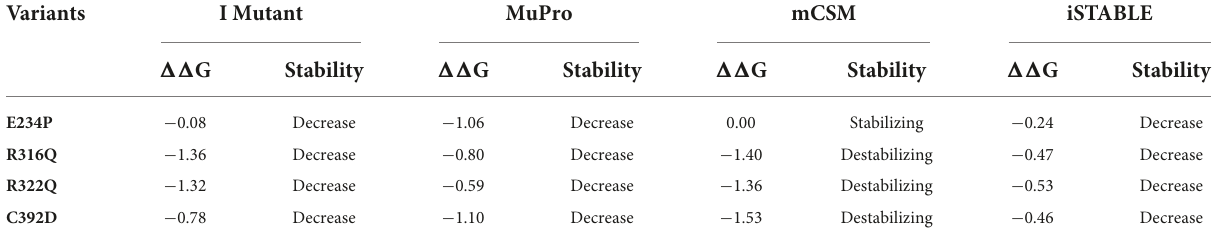
TABLE 2 Stability analysis of FTO